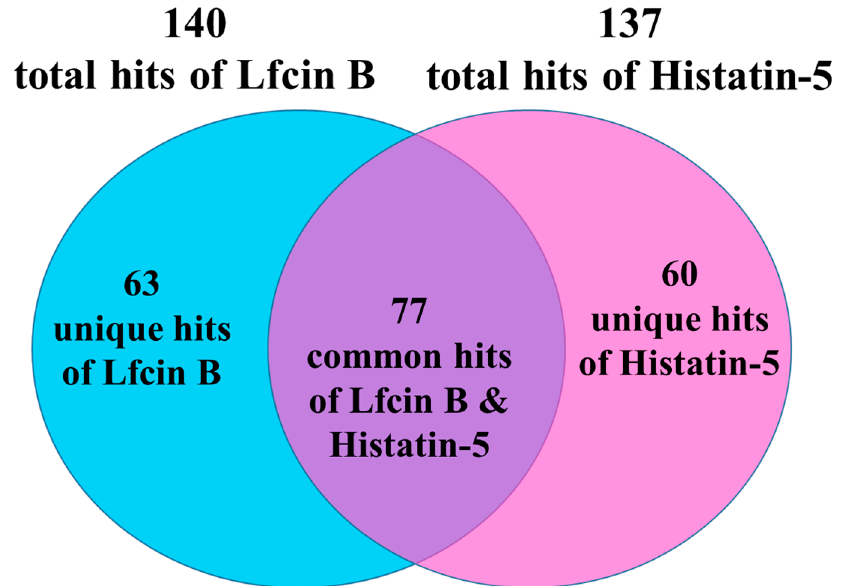
Figure 3. Unique and common hits of Lfcin B and Histatin-5 identified from yeast proteome microarrays. The protein targets of Lfcin B and Histatin-5 identified from yeast proteome microarrays are 140 and 137, respectively. These identified hits of Lfcin B and Histatin-5 were categorized as unique and common hits. Unique protein targets that are present only in Lfcin B are 63 hits whereas the unique protein targets that are present only in Histatin-5 are 60 hits. 77 protein targets were common to both Lfcin B and